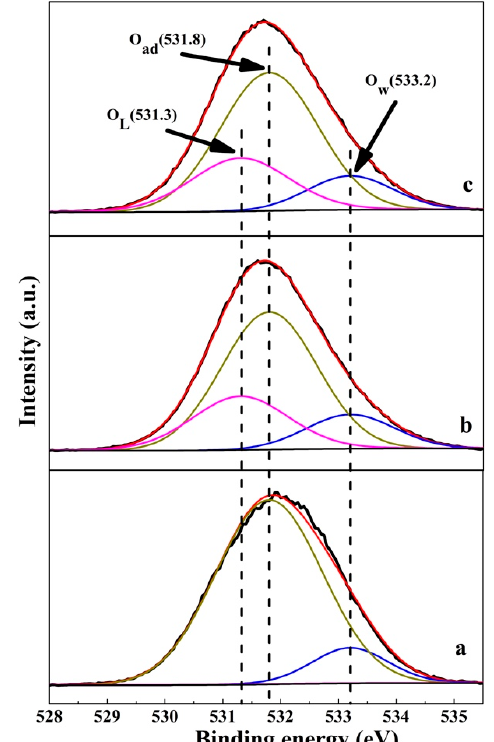
Figure 5. XPS O 1 s spectra of the solid products after lithium recovery from LiAl-LDHs at varied initial Li + concentrations ( a ) 6.75 g/L, ( b ) 3.375 g/L, ( c ) 1.6875 g/L.